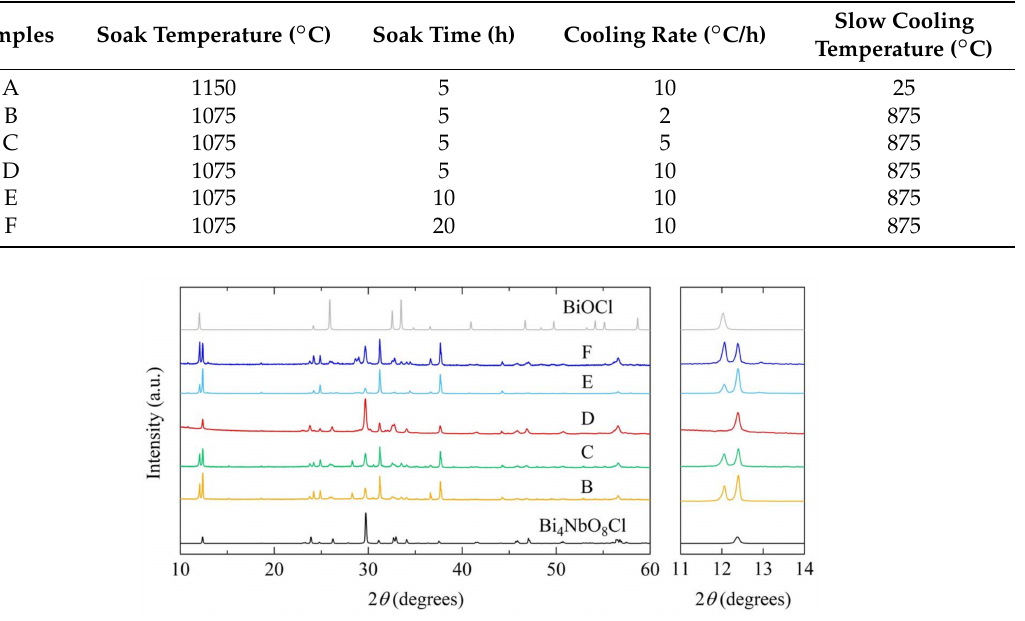
Table 1. Conditions for single crystal growth of Bi 4 NbO 8 Cl.